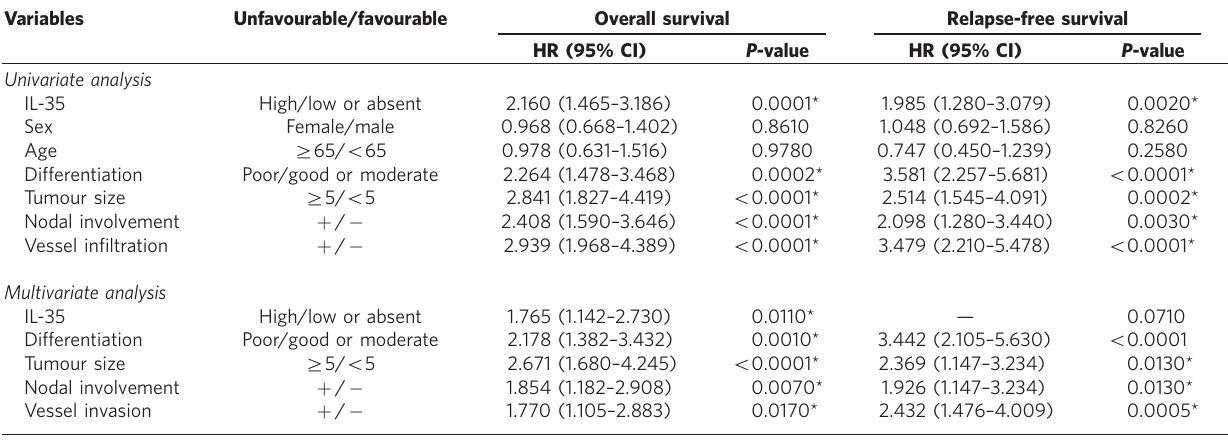
Table 2 | Cox’s proportional hazard model analysis of prognostic factors in patients with pancreatic carcinoma.